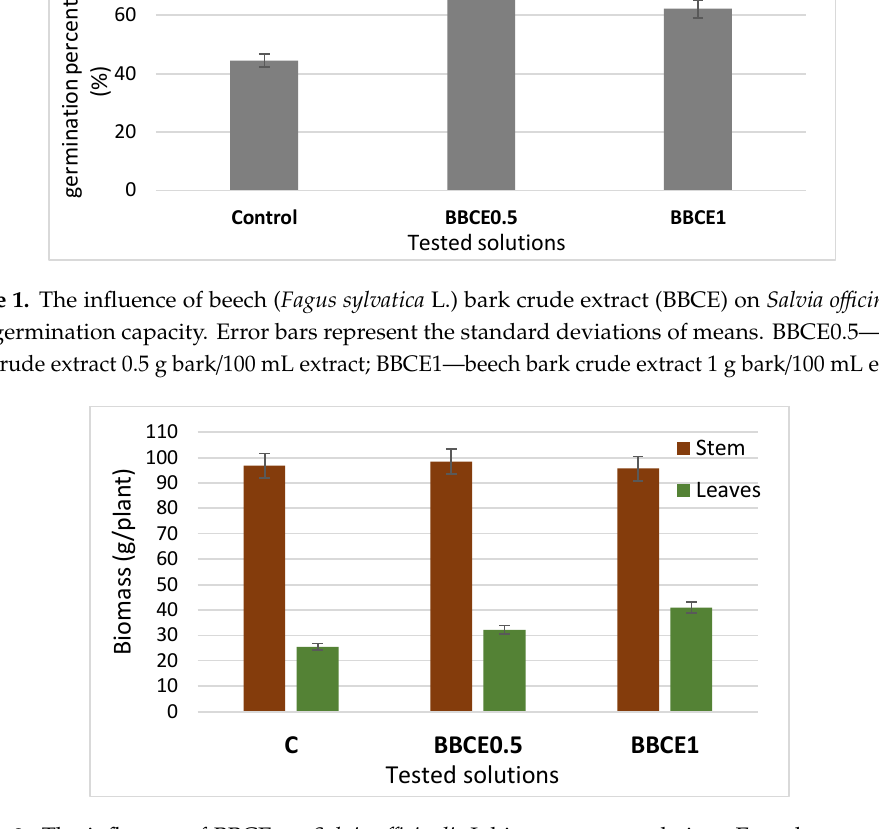
Figure 2. The influence of BBCE on Salvia officinalis L biomass accumulation. Error bars represent the standard deviations of means. C — Control; BBCE0.5 — beech bark crude extract 0.5 g bark/100 mL extract; BBCE1 — beech bark crude extract 1 g bark/100 mL extract.